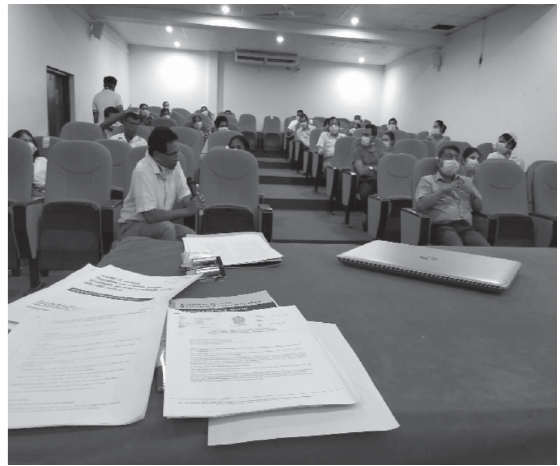
Figure 1: COVID-19 Working Committee